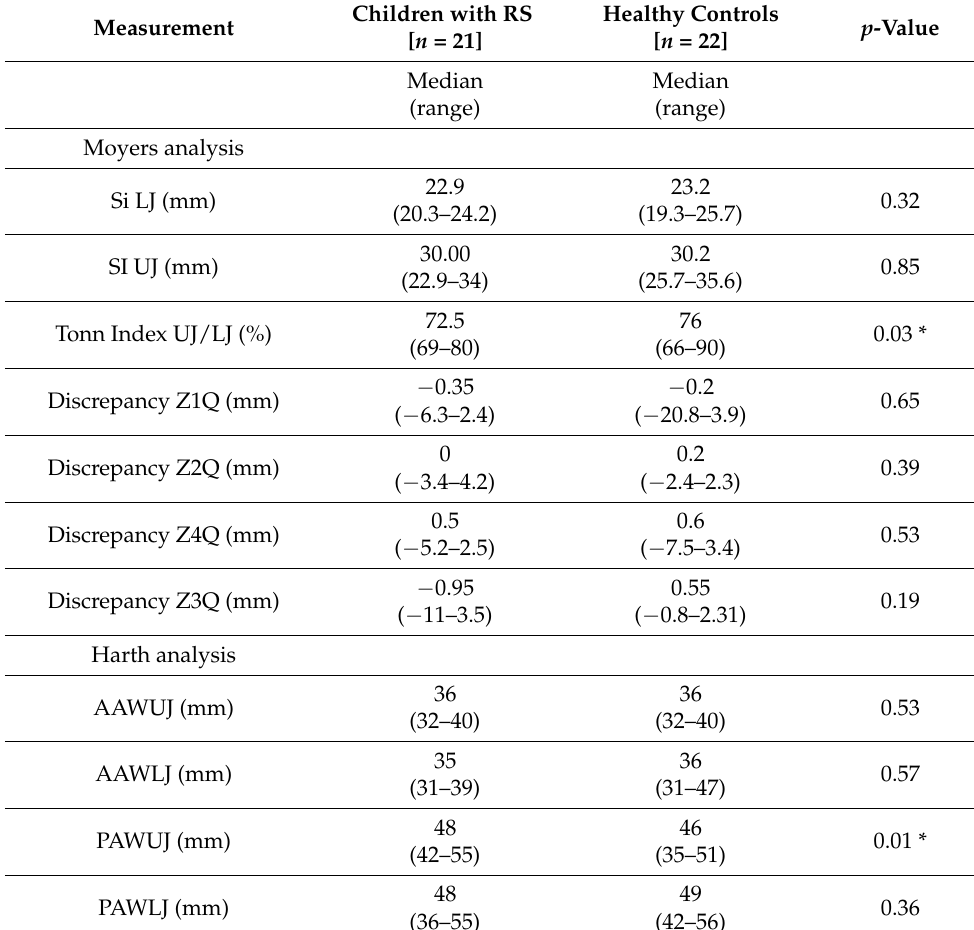
Table 4. Digital study casts analysis of children with Robin sequence (RS) versus healthy control group. The total mesio-distal width of the four incisors of the upper and lower jaws according to Moyers and the anterior/posterior arch width measurements of the upper and lower jaws according to Harth were evaluated